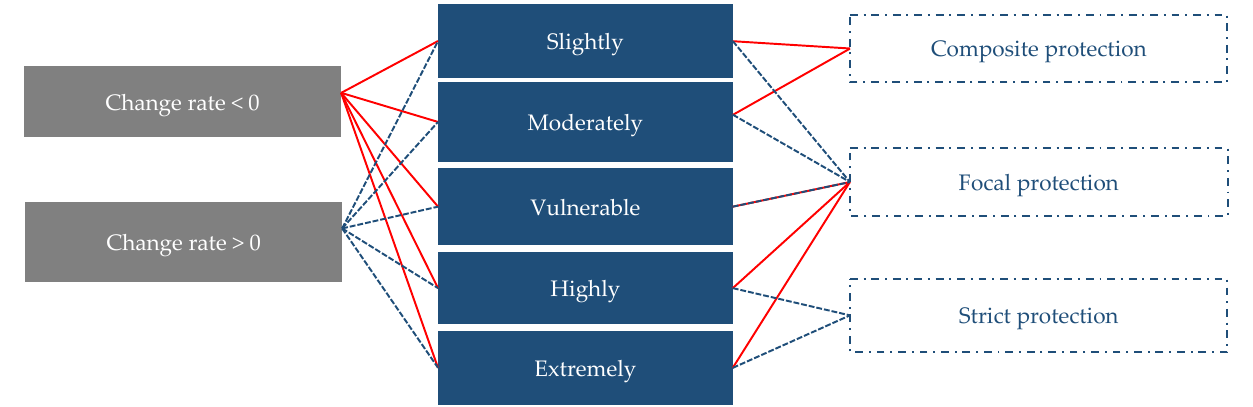
Figure 3. A framework for spatial conservation optimization for forest vulnerability.